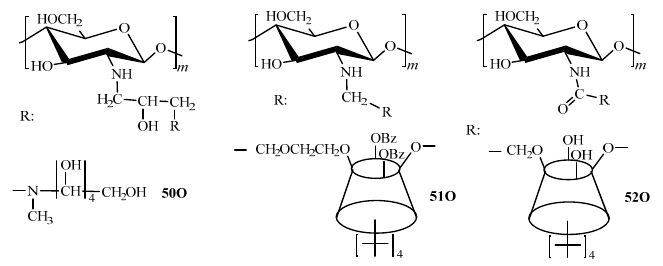
Figure 6. Structure of O-containing derivatives of chitosan with linker: 50O —chitosan resin derivatized with N -methyl- D -glucamine; 51O —calix[4]arene-crosslinked chitosan (5,11,17,23-tetra- tert -butyl-26,28-dibenzoyloxycalix[4]arene chitosan); 52O —calix[4]arene-crosslinked chitosan (5,11,17,23-tetra- tert -butyl-26,28-dihydroxycalix[4]arene chitosan).